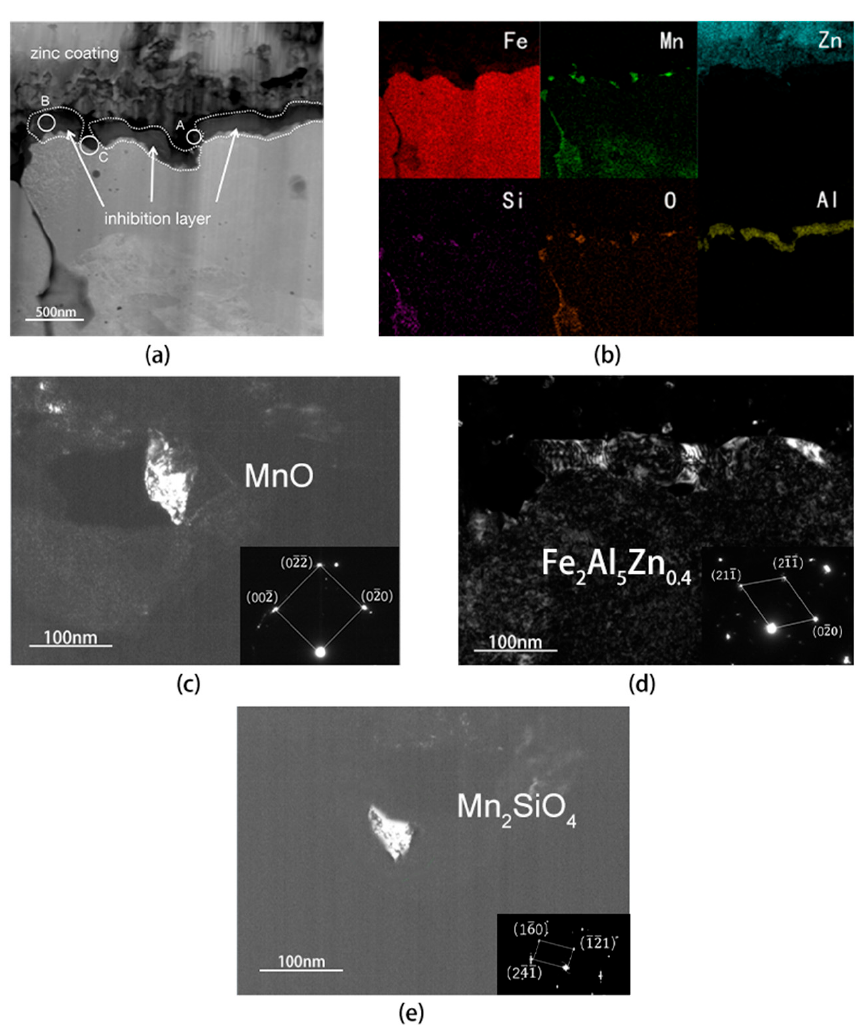
Figure 11. ( a ) TEM analysis of the Zn coating/Fe substrate interface of the galvanized sample1#. ( b ) cross-sectional elemental maps of the area. ( c ) Dark filed image and diffraction pattern of the oxide particle corresponding to zone A in ( a ). ( d ) Dark filed image and diffraction pattern of the inhibition layer corresponding to zone B in ( a ).